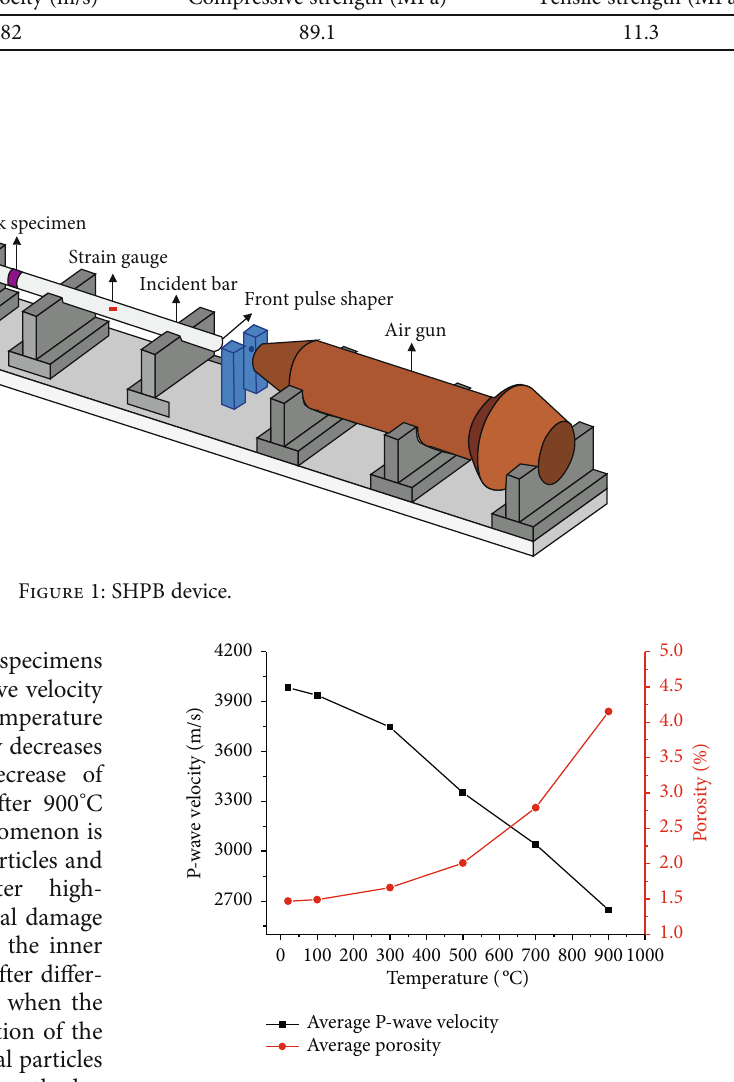
Figure 2: Variation in P-wave velocity and porosity with temperature.